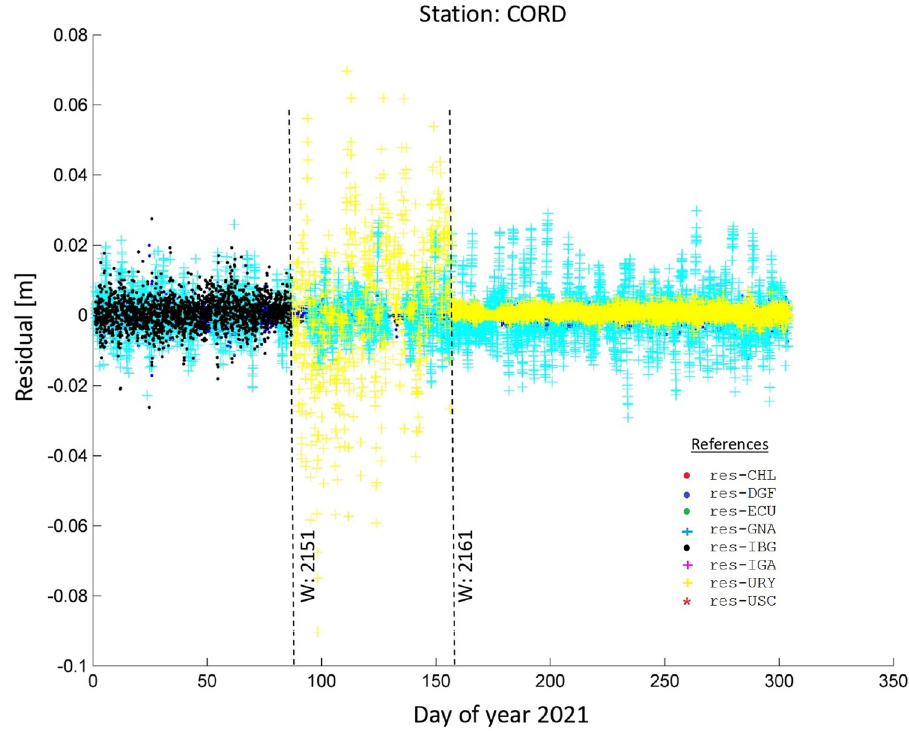
residuals in CORD, SIRGAS - CON Station, day of year Figure 8: ZTD i tj